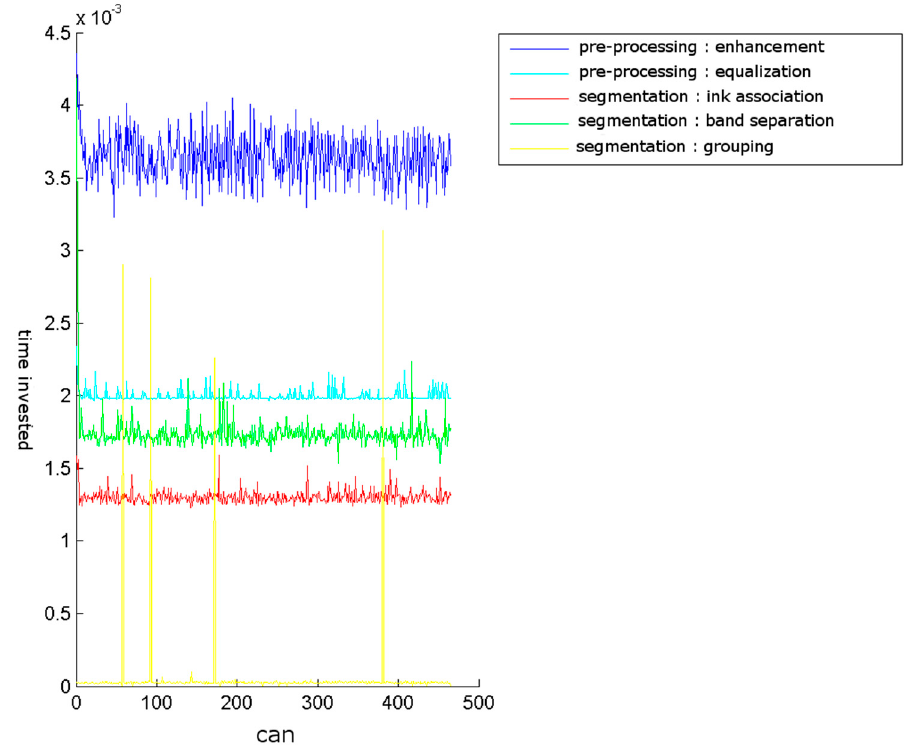
Figure 23. Breakdown of the times by stages. Enhancement and equalisation, the two pre-processing phases, were the most time-consuming. The grouping stage had considerable ups and downs because it depends on the number of clusters required. Each grouping represents a new grouping cycle. Too many groupings indicate an incorrect system calibration.